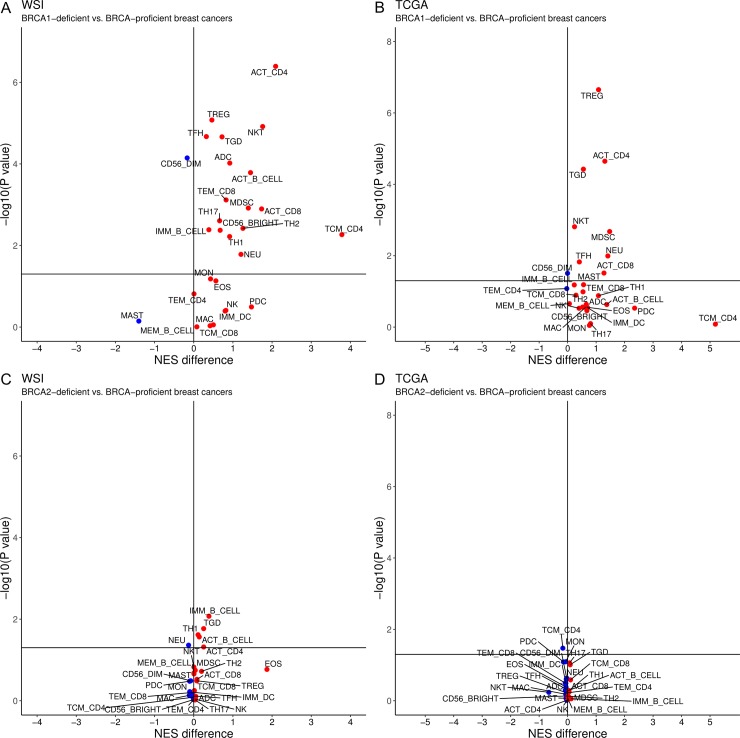
Relative enrichment of immune infiltrates in BRCA1- (A-B) and BRCA2-deficient (C-D) breast cancers compared to BRCA-proficient breast cancers from WSI and TCGA. ACT_B_cell: Activated B cell, ACT_CD4: Activated CD4 T cell, ACT_CD8: Activated CD8 T cell, ADC: Activated dendritic cell, CD56_BRIGHT: CD56bright natural killer cell, CD56_DIM: CD56dim natural killer cell, EOS: Eosinophil, IMM_B_CELL: Immature B cell, IMM_DC: Immature dendritic cell, MAC: Macrophage, MAST: Mast cell, MDSC: Myeloid-derived suppressor cell, MEM_B_CELL: Memory B cell, MON: Monocyte, NEU: Neutrophil, NK: Natural killer cell; NES: Normalized enrichment score, NKT: Natural killer T cell, PDC: Plasmacytoid dendritic cell, TCM_CD4: Central memory CD4 T cell, TCM_CD8: Central memory CD8 T cell, TEM_CD4: Effector memory CD4 T cell, TEM_CD8: Effector memory CD8 T cell, TFH: T follicular helper cell, TGD: γδ T cell, TH1: Type 1 T helper cell, TH17: Type 17 helper cell, TH2: Type 2 T helper cell, TREG: Regulatory T cell.